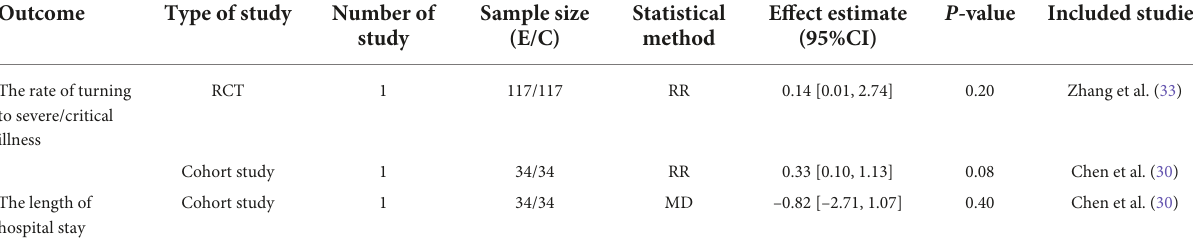
TABLE 4 Comparison of efficacy outcomes in the SFJD + WM group vs. the WM group in COVID-19